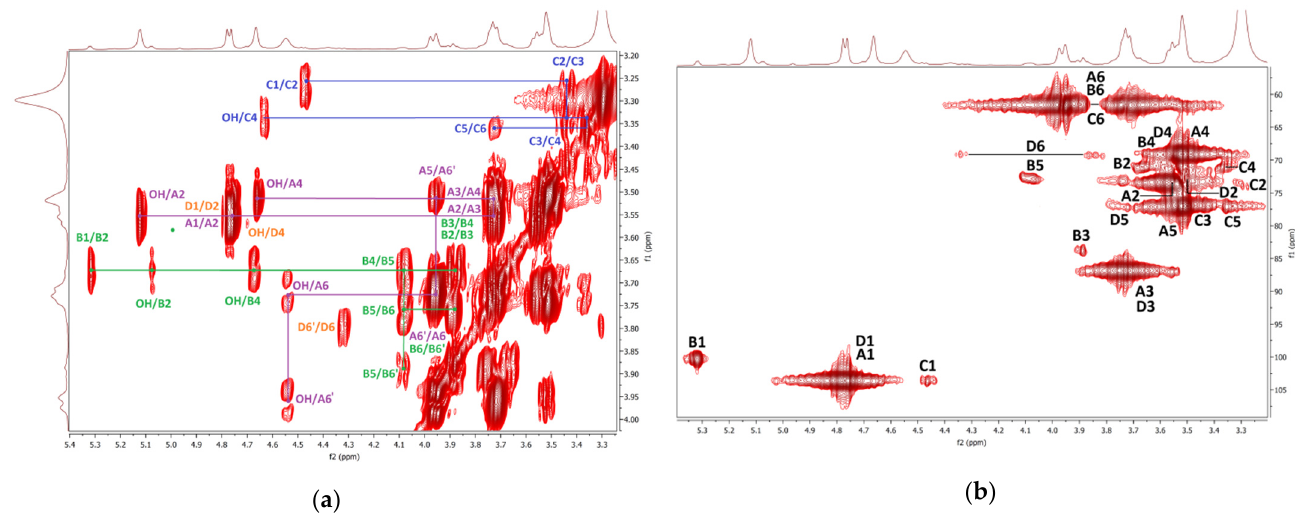
Figure 9. 1 H, 1 H COSY ( a ) and 1 H, 13 C HMQC ( b ) NMR spectra of the fraction F3 .